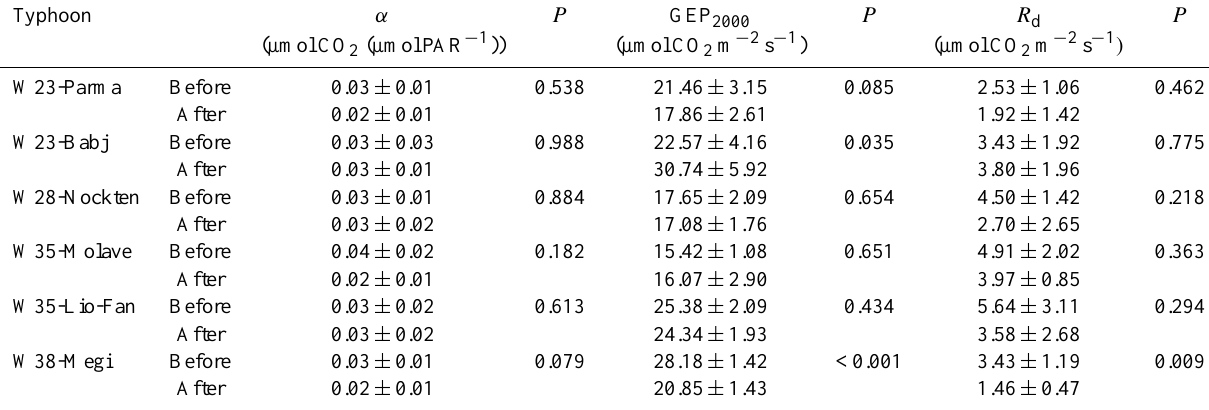
Table 2. Model parameters of light response curves before and after each typhoon landfall during 2009 and 2012. α is the ecosystem quantum yield, GEP 2000 indicates the gross ecosystem productivity when photosynthetically active radiation reach 2000µmolm − 2 s − 1 , R d represents ecosystem respiration, and P represents significant difference in model parameters comparing before and after typhoon. Typhoon